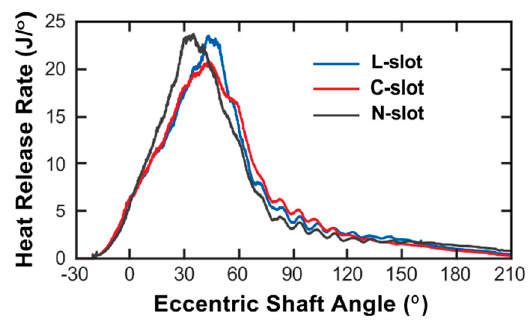
Figure 7. Simulated HRR for L-slot (baseline), C-slot, and N-slot configurations.